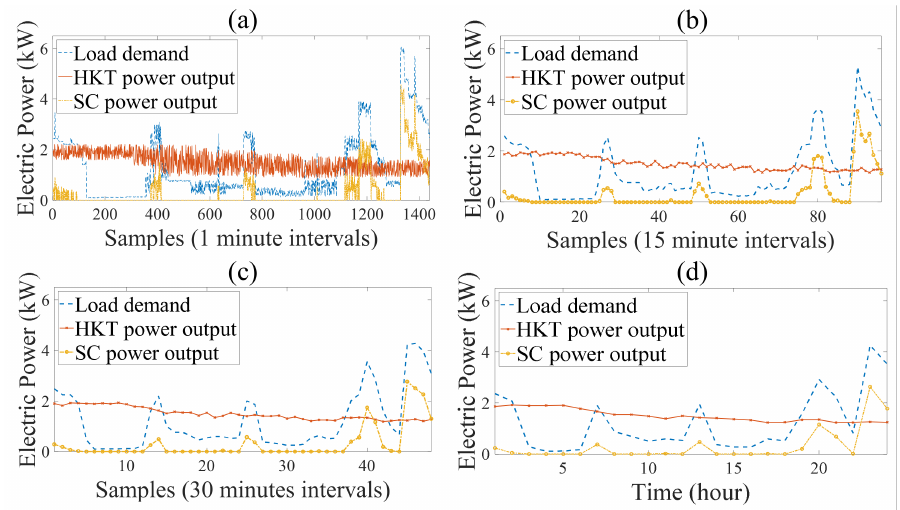
Figure 7. Energy balance of the renewable system connected to the grid. Data sampling at different time intervals: ( a ) 1 min, ( b ) 15 min, ( c ) 30 min and ( d ) every hour (60